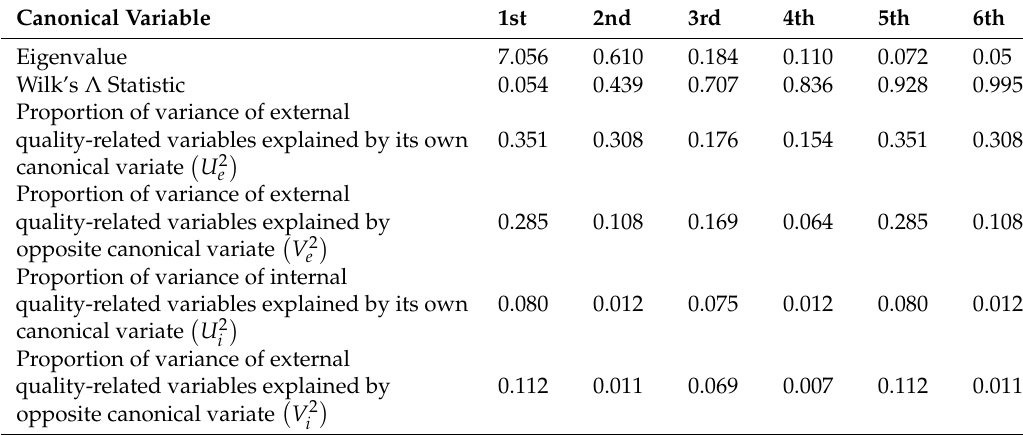
Table 5. Proportion of explained variance, eigenvalues and percentages of explained common variance associated with each factor of internal and external egg quality-related trait, excluding yolk and white pH, in Utrerana hens compared to laying lineage (n =